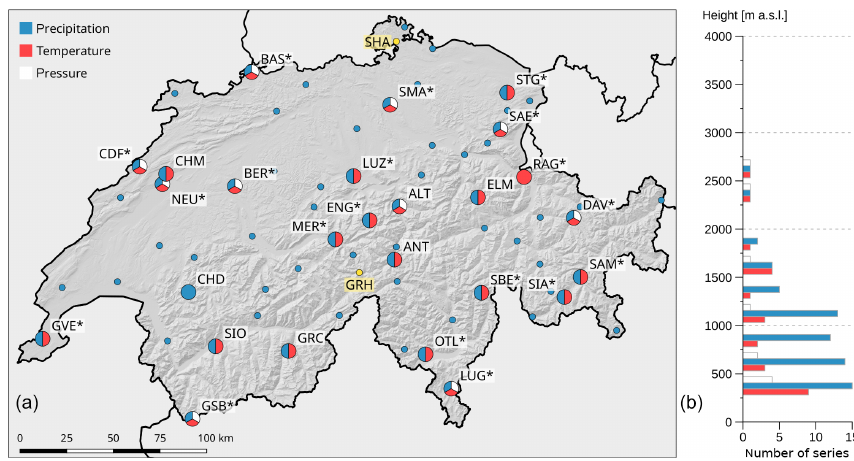
Figure 1. Station map. (a) Measured variables are indicated as colours. Labelled pie charts represent NBCN climate monitoring stations. Additional NBCN precipitation stations are indicated as small blue dots. Stations that were used for temperature assimilation are marked by an asterisk. Yellow dots represent series used for station-based validation. (b) The vertical distribution of measurement series is indicated by altitude class for each